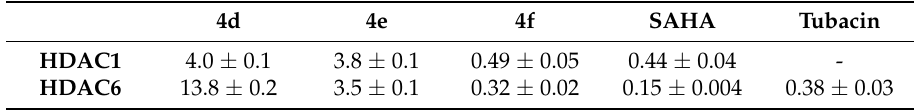
Table 2. HDAC inhibition [IC 50 ( µ M)] 1 by compounds 4 d – f .